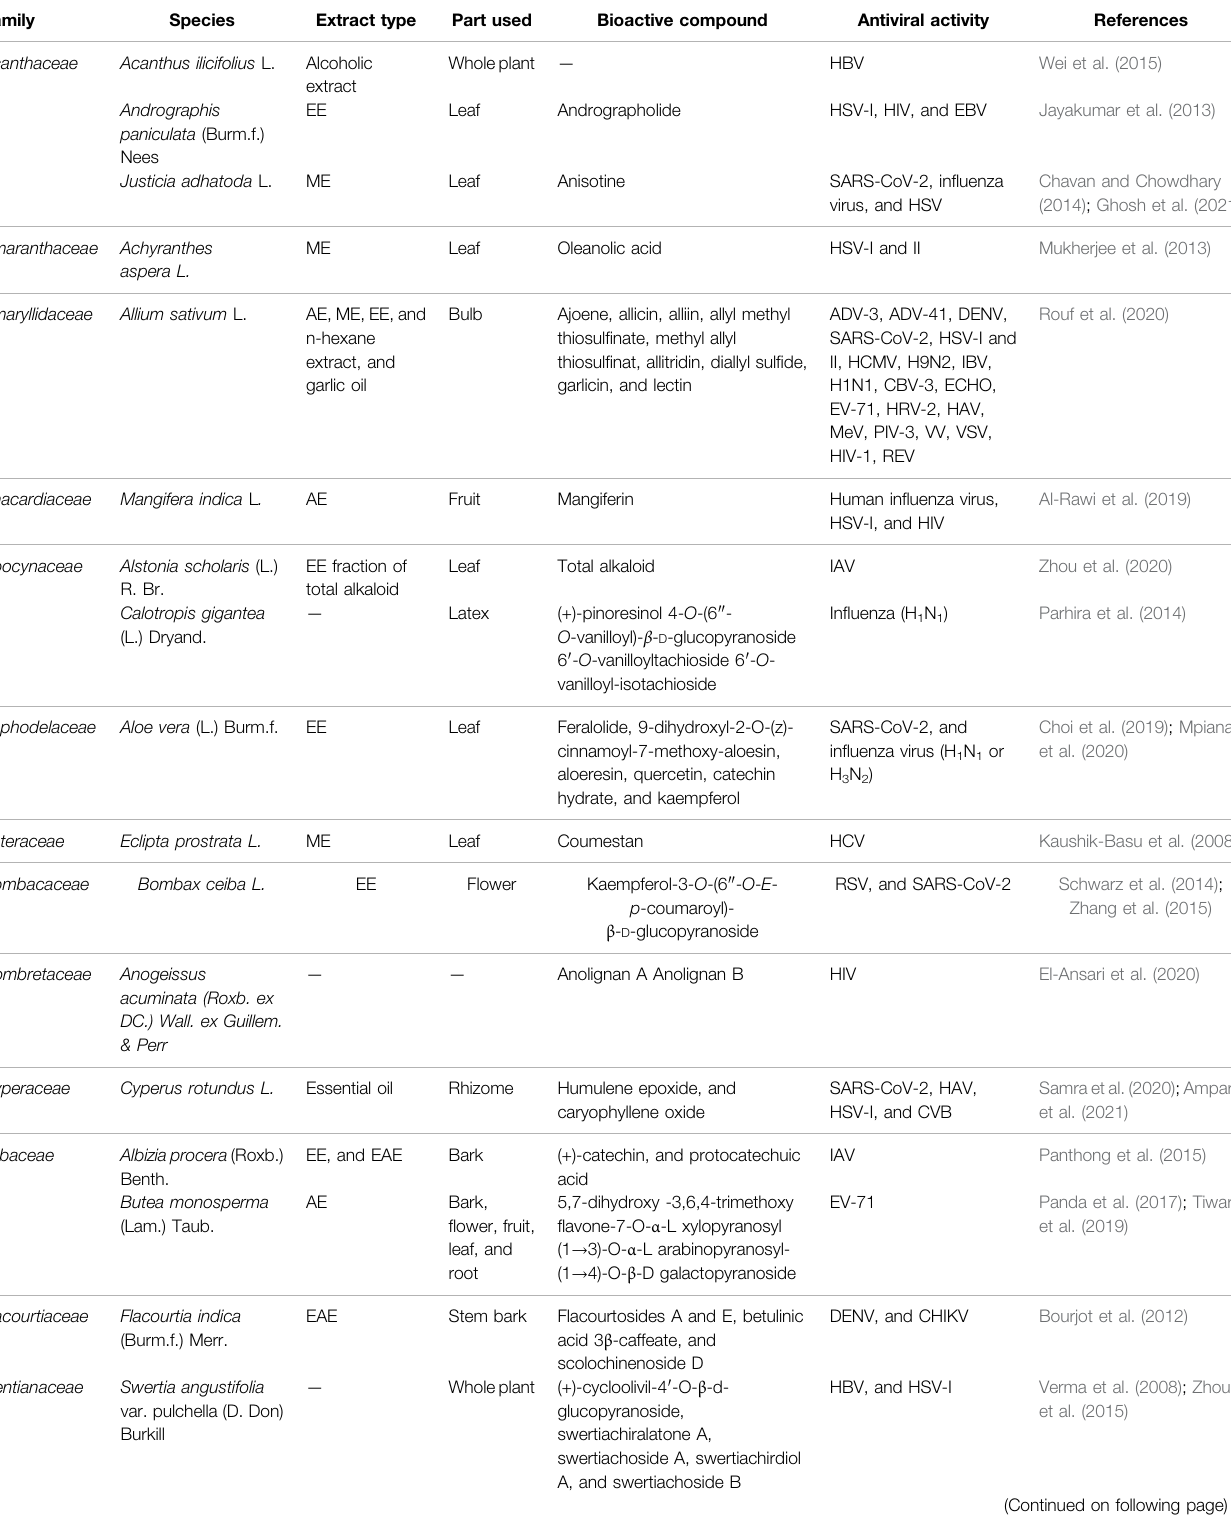
TABLE 1 | Overview of the effects of medicinal plants extracts on common viral